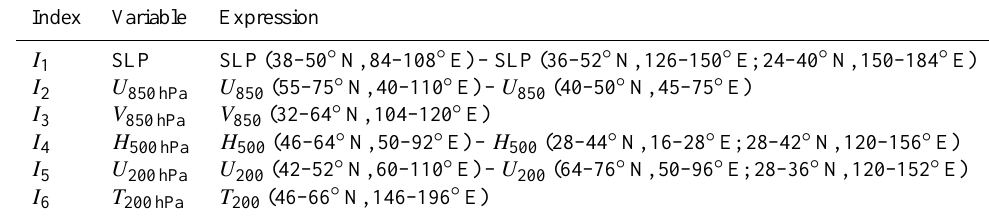
Table 2. List of the definitions for the six circulation indices. Index Variable